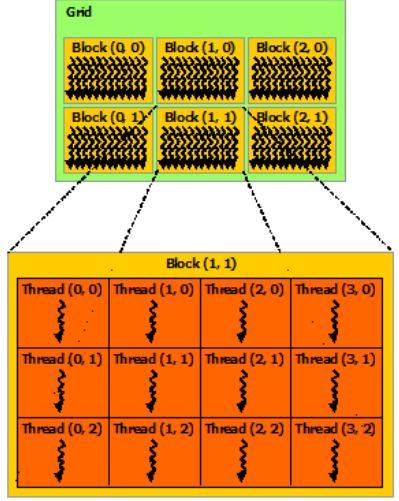
Figure 4. The grid of threads in GPU - This can be one , two and three dimensions